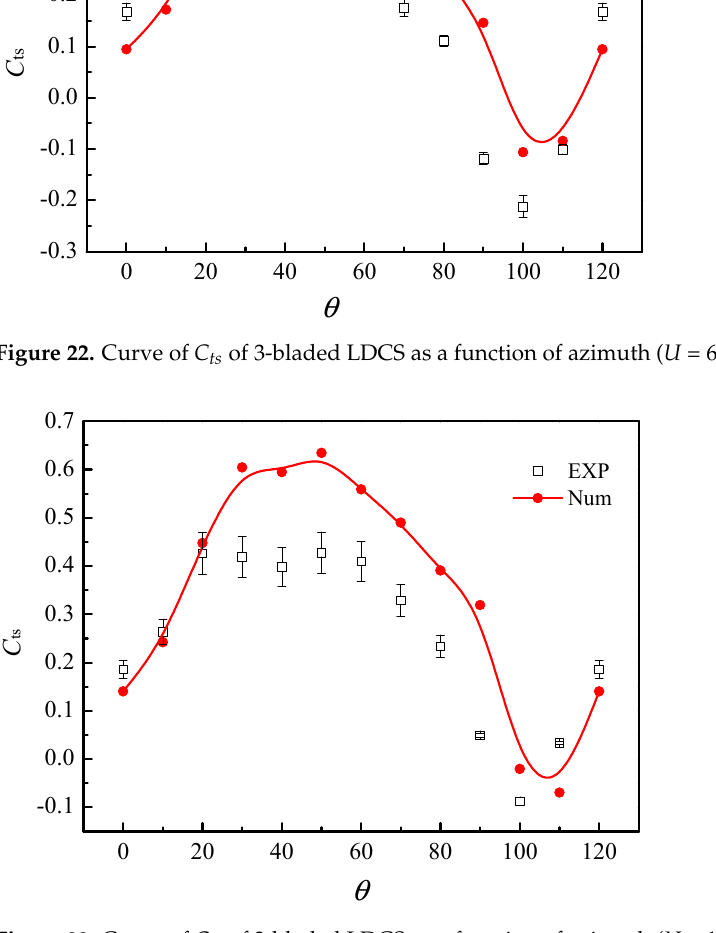
Figure 23. Curve of C ts of 3-bladed LDCS as a function of azimuth ( U = 10 m/s).